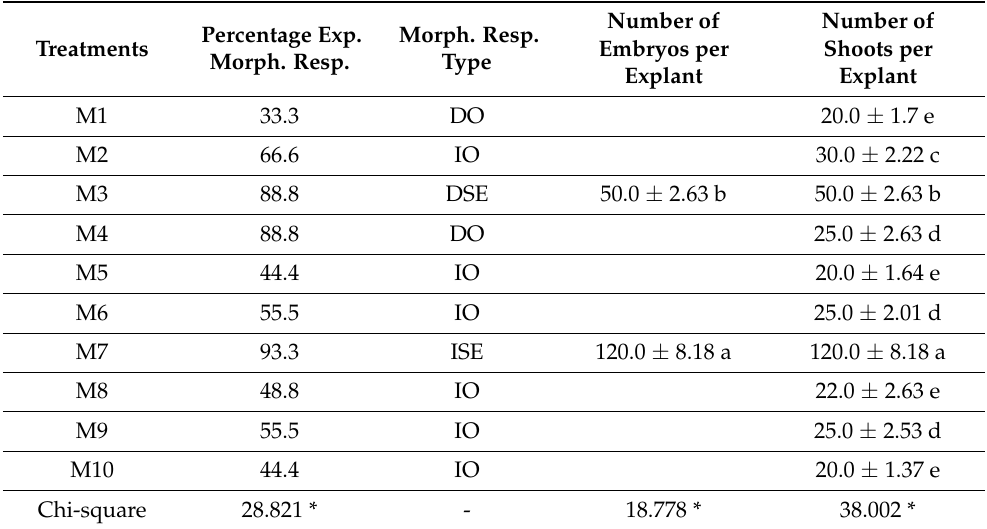
Table 2. Morphogenic response of leaf segments of ‘MD2’ hybrid pineapple seedlings grown in different treatments. Percentage Exp. Treatments Morph.